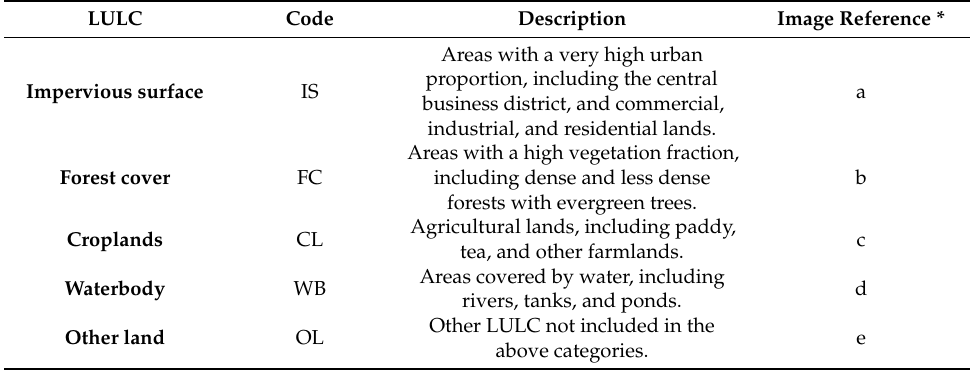
Areas with a very high urban proportion, including the central business district, and commercial, industrial, and residential lands. Areas with a high vegetation fraction, including dense and less dense forests with evergreen trees.